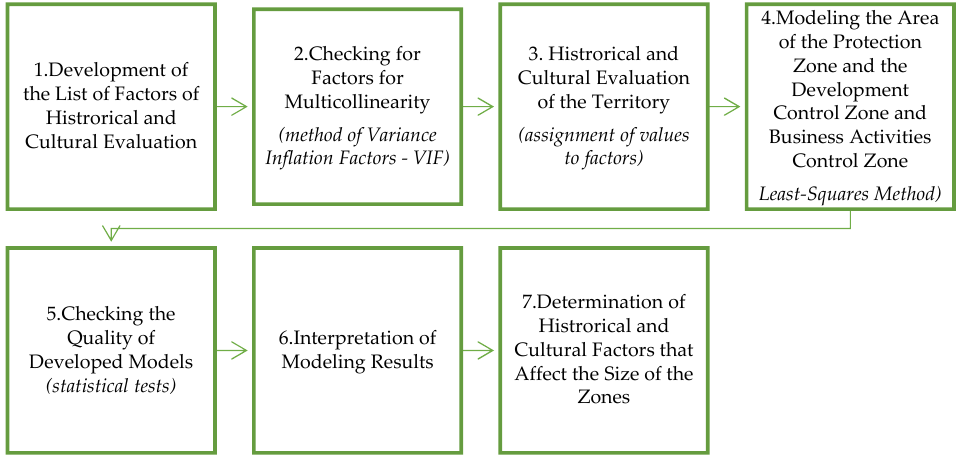
Figure 5. Stages of determining the mathematical form of the size of protection zones of cultural heritage sites.